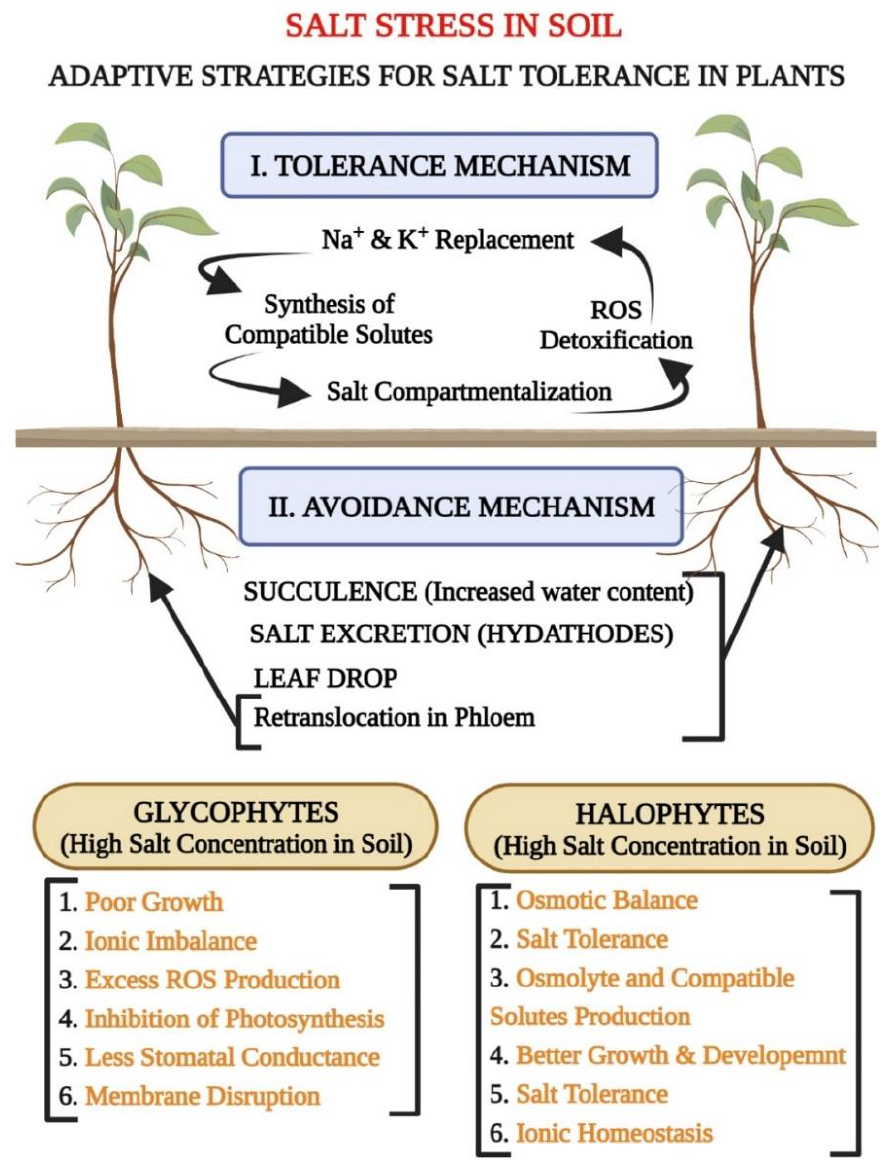
Figure 2. Schematic representation of adaptive strategies for salt tolerance in plants, including tolerance and avoidance mechanisms; the differentiation of plants into glycophytes and halophytes based on their responses to salt stress.